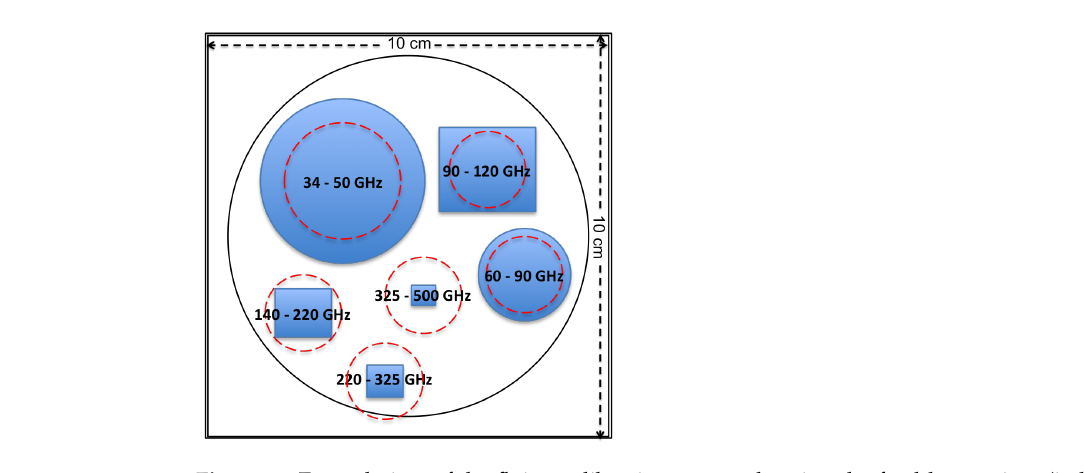
Figure 9. Frontal view of the flying calibration source showing the feed-horns sizes (in blue) and the corresponding wave-guide flanges (red lines), which determine the size envelope at the highest frequencies.